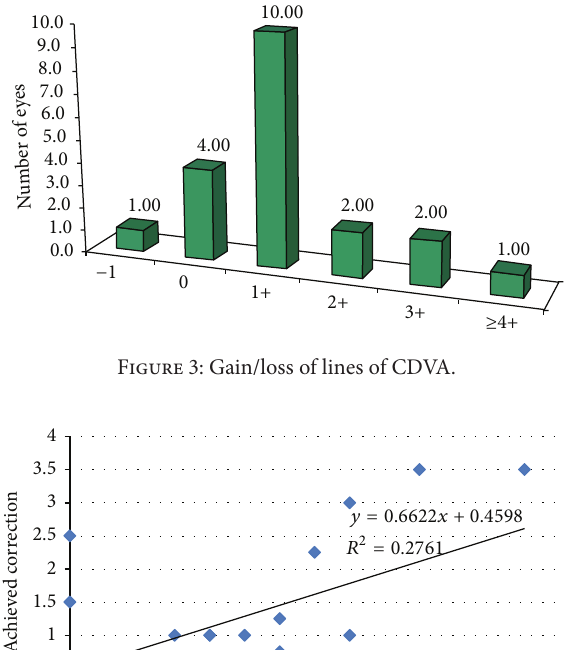
Figure 4: Linear regression analysis graph of planned and achieved cylindrical